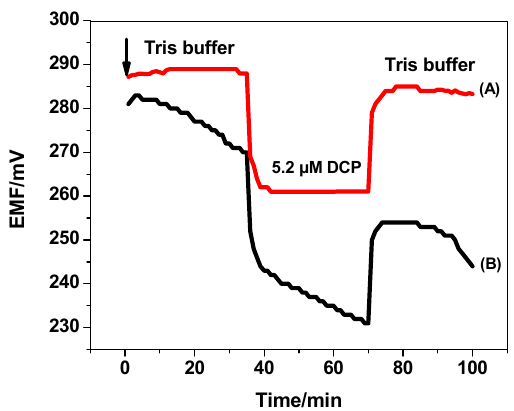
Figure 10. Water-layer tests for the DCP-ISE (A) with and (B) without PANI as the solid contact.